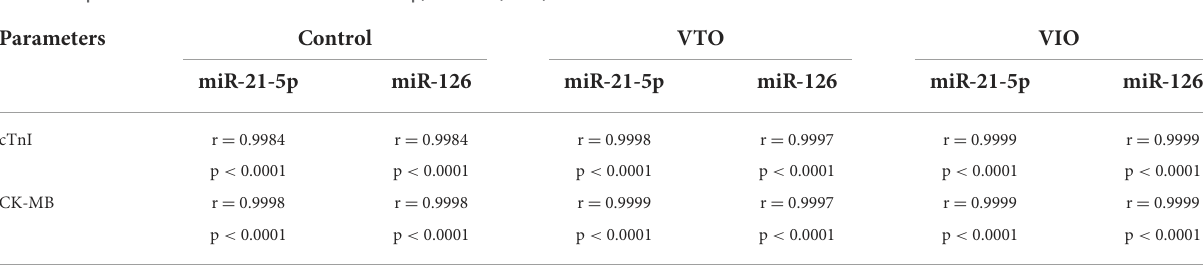
TABLE 4 Spearman correlation between miR-21-5p, miR-126, cTnI, and CK-MB. Parameters Control VTO VIO miR-21-5p miR-126 miR-21-5p